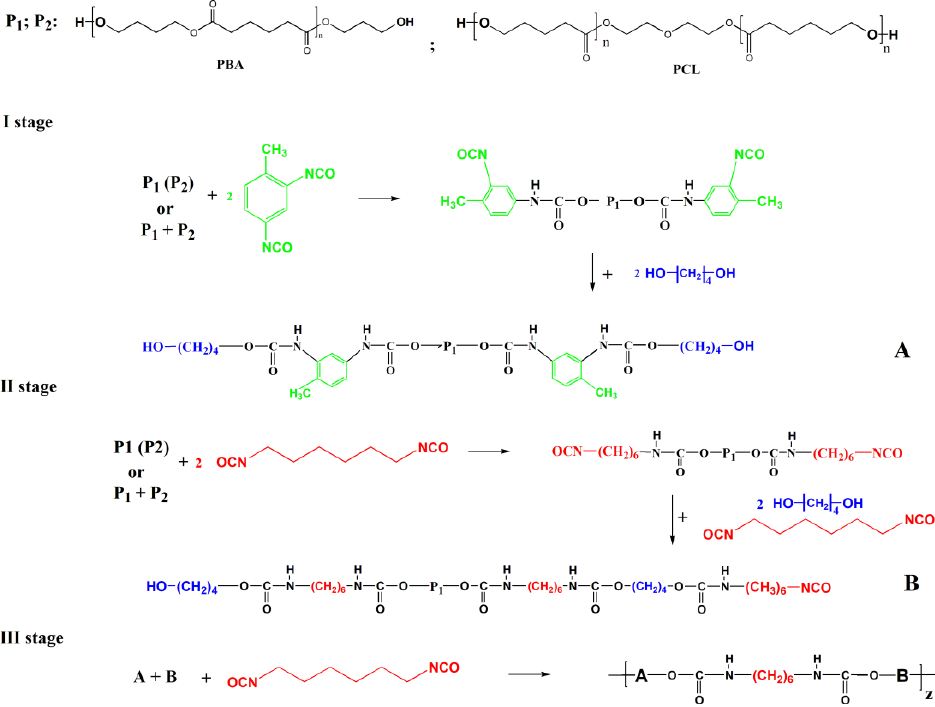
Table 1. Chemical composition of